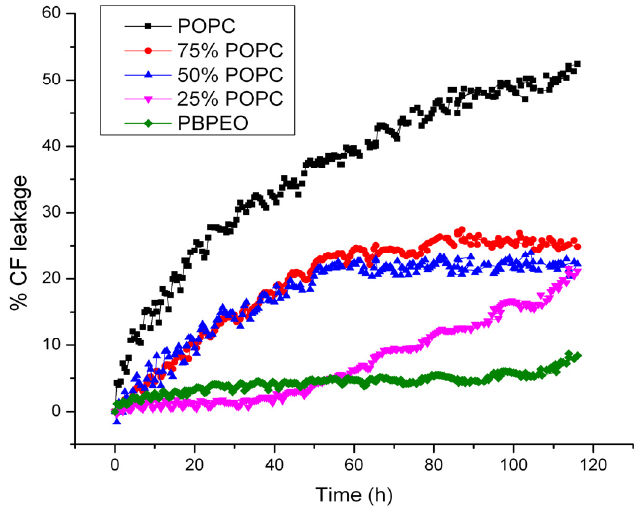
Figure 6. CF release from vesicles over 120 h at room temperature. 50 mM CF was encapsulated in the vesicles ( i.e. , at self-quenching concentration). As a result, fluorescence intensity will increase when CF is released from the vesicles in the surrounding aqueous buffer. CF was excited at 480 nm and fluorescence emission at 520 nm was measured. The percentage of CF release over time is presented as 100 × ( F − F the initial fluorescence of CF, F is the fluorescence of CF at time interval t and F fluorescence intensity after complete release of CF after adding 0.5% Triton